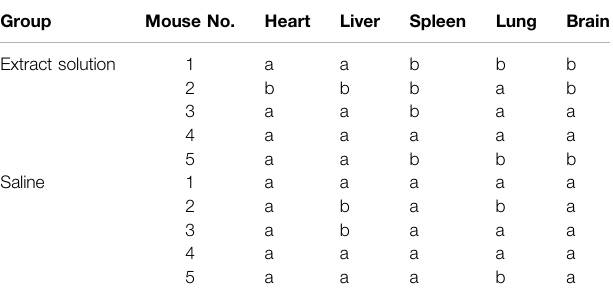
TABLE 5 | Histopathology observations of the paraf fi n sections of the murine organs excised after 72 h of the intravenous injection with Fe 3 O 4 @Agar/HA extract solution or saline. Group Mouse No. FIGURE 3 |